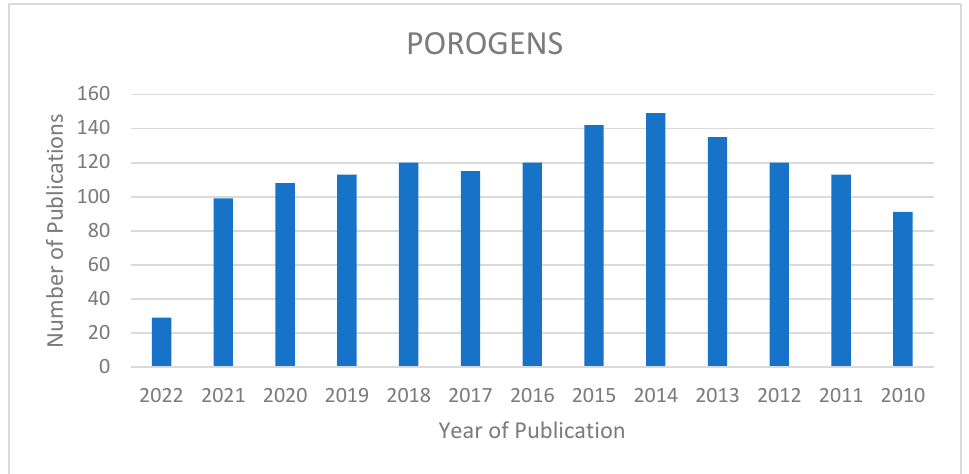
Figure 3. Publication record of material fabrication using different types of porogens over the last decade (https://pubmed.ncbi.nlm.nih.gov, accessed on 22 March 2022.).